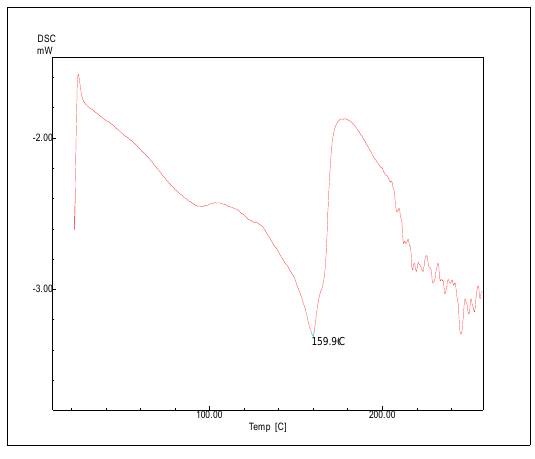
Figure 12. (A) DSC thermogram For F18 atorvastatin calcium